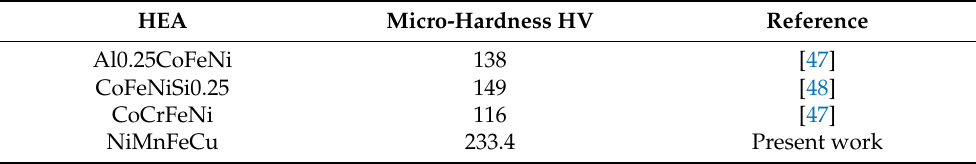
Table 5. Micro-hardness of 3D transition metal based HEAs reported from the literature.